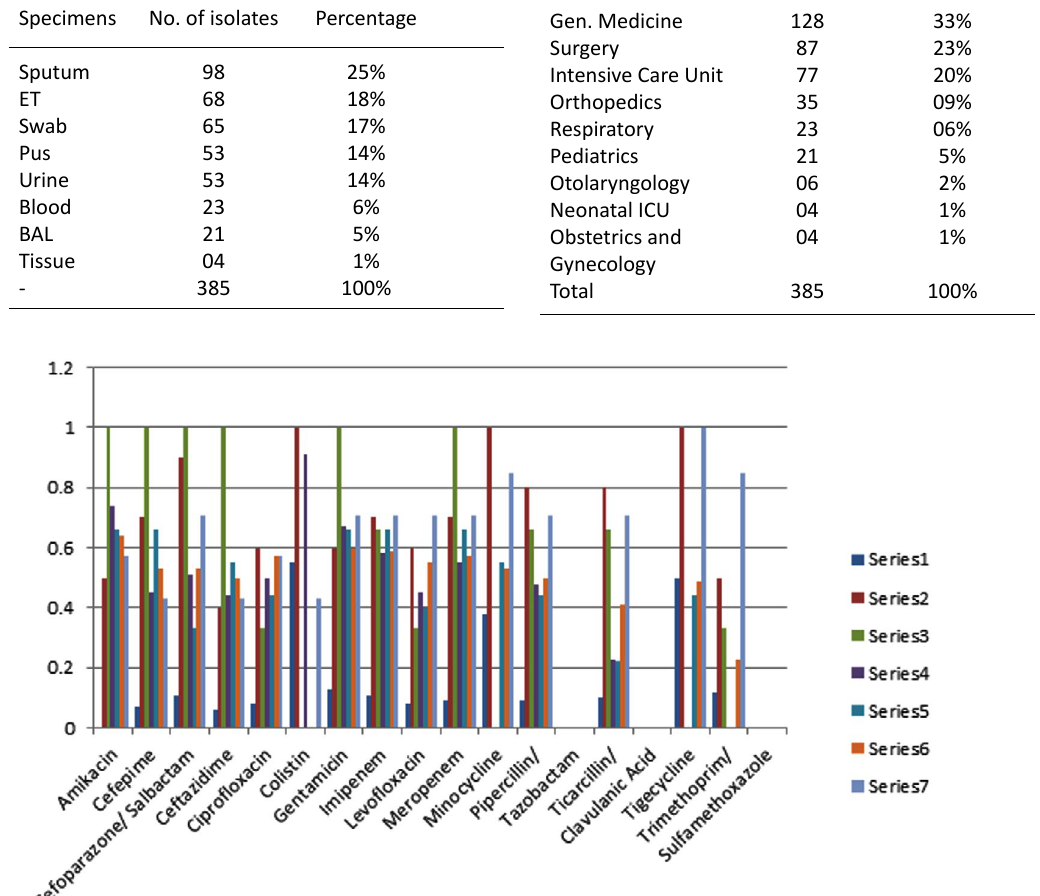
Fig. 1. Antibiotic sensitivity pattern of isolates. Legend for Fig. 1 . shows antibiotic sensitivity pattern of 385 isolates; X axis shows names of Antibiotics and Y axis shows sensitivity index from 0 to 1,maximum sensitivity 1 means 100% sensitive, Organisms in series 1 Acinetobacter baumannii (n=118), series 2 Acinetobacter lwoffii (n=10), series 3 Morganella morganii (n=3), series 4 Pseudomonas aeruginosa (n=74), Series 5 Pseudomonas putida (n=9), Series 6 Pseudomonas sp.(n=164), series 7 Sphingomonas paucimobilis (n=7) (data on which this graph is prepared is given in